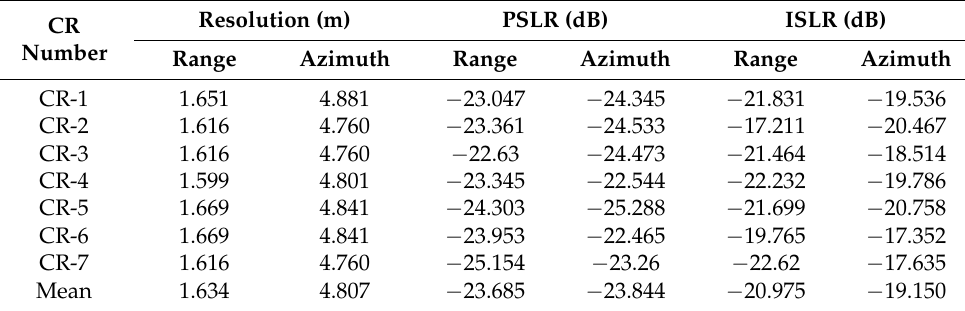
Table 4. Image quality parameters from each CR for FSI mode data on 15